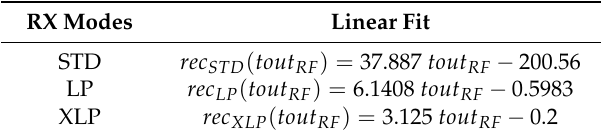
Table 9. Empirical model for reception: electric charge drained in reception